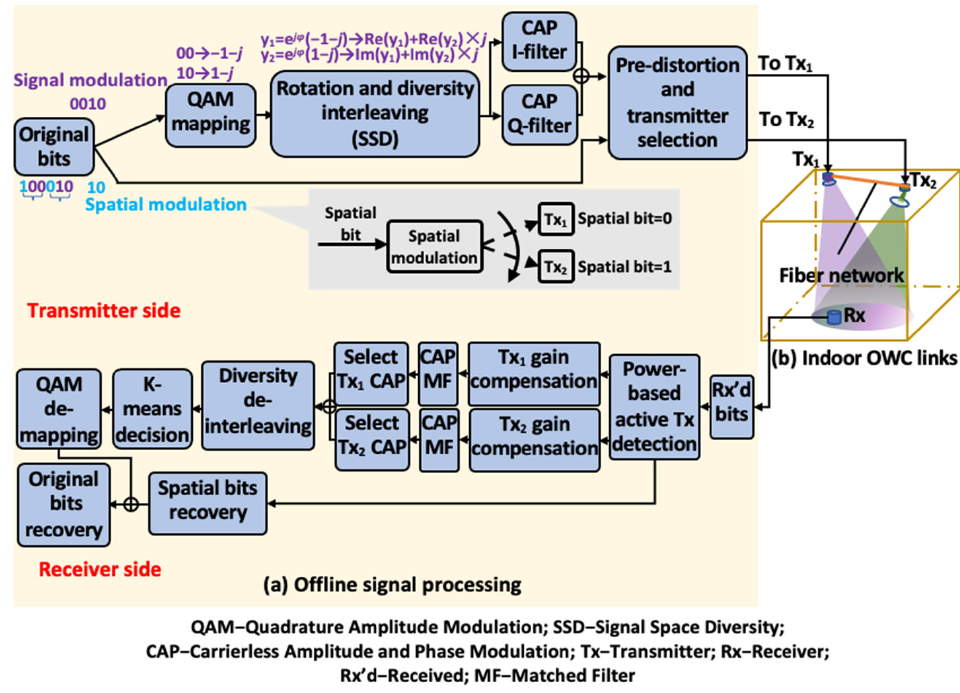
Figure 1. The architecture of the overall indoor OWC system.